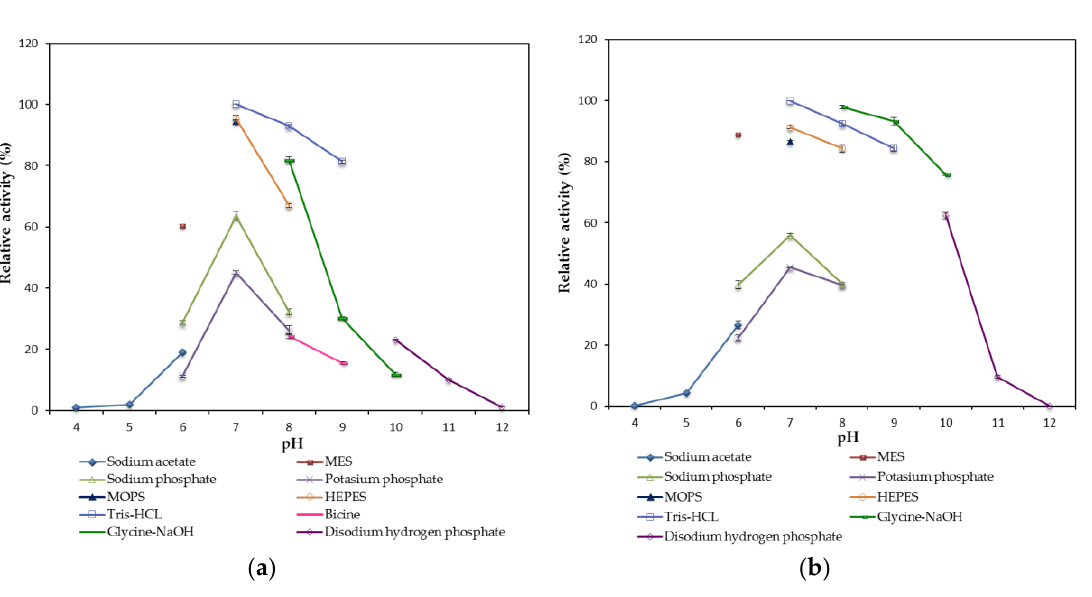
Figure 6. Effects of pH on the mature rHZ lipase. ( a ) The optimum pH of mature rHZ lipase activity. The enzyme was incubated with substrate (olive oil) emulsion prepared in various buffers with pHs from 4 to 12 at 65 ◦ C for 30 min. The activities of the rHZ lipase against different buffer are shown as values relative to the optimum pH (pH 7.0). ( b ) Effect of pH on the mature rHZ lipase stability. The enzyme was pre-incubated in various buffers with pHs ranging from 4 to 12 at 50 ◦ C for 30 min. Lipase assay was done at 65 ◦ C for 30 min using the substrate emulsion of olive oil and Tris-HCl, pH (65 ◦ C) 7.0. The relative activities of the rHZ lipase against different buffer are shown as values relative to the optimum pH (pH 7.0). The buffers used were at 50 mM concentration. Data are means ± standard deviations of three determinations ( n = 3) and the standard deviations are indicated as error bars. When the error bar cannot be seen, the deviation is less than the size of the symbol.